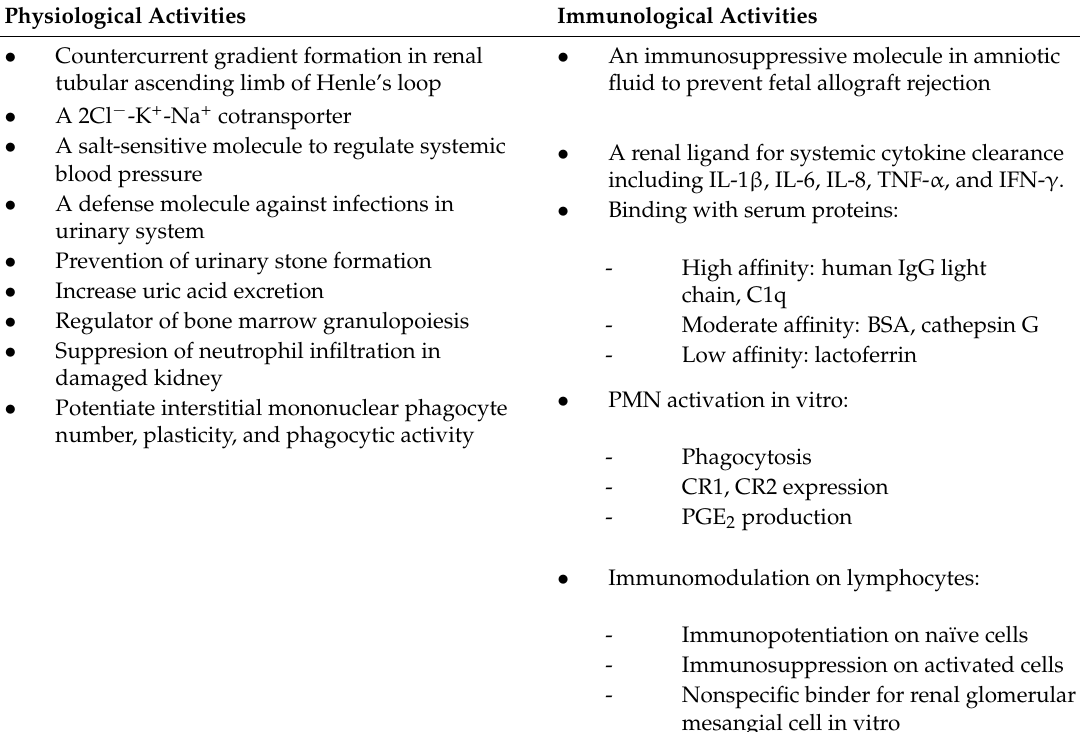
Table 1. Physiological and immunological activities of Tamm–Horsfall